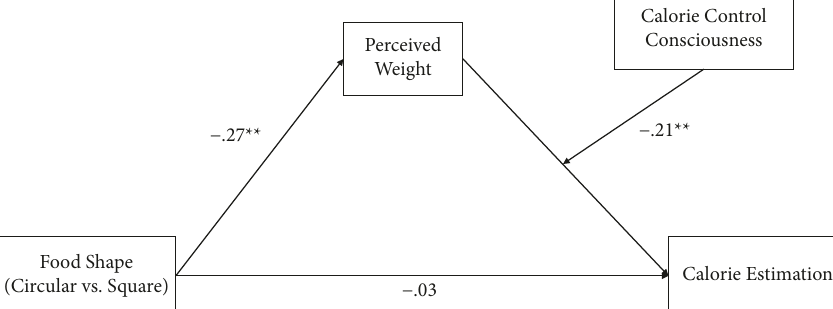
Figure 2: Moderated Mediation Effect. Notes : All beta values were standardized coefficients: ∗ p < 0 . 05, ∗∗ p < 0 .